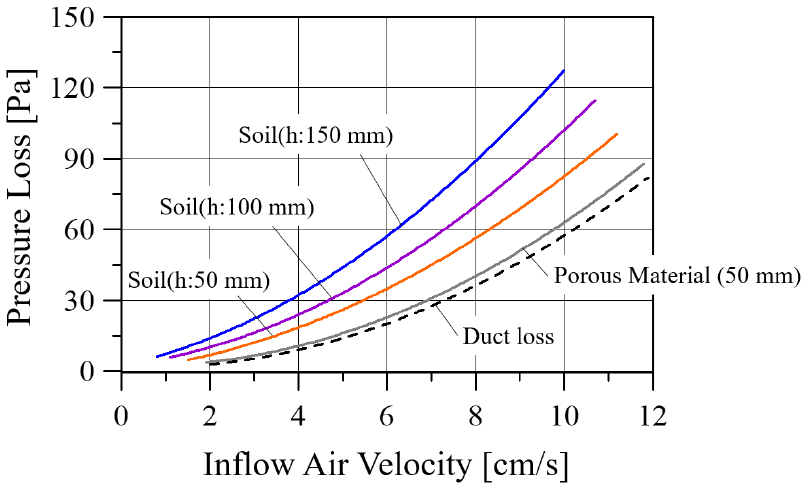
Figure 5. Pressure loss according to the height of the soil, the porous material, and the duct with regards to inflow air velocity.